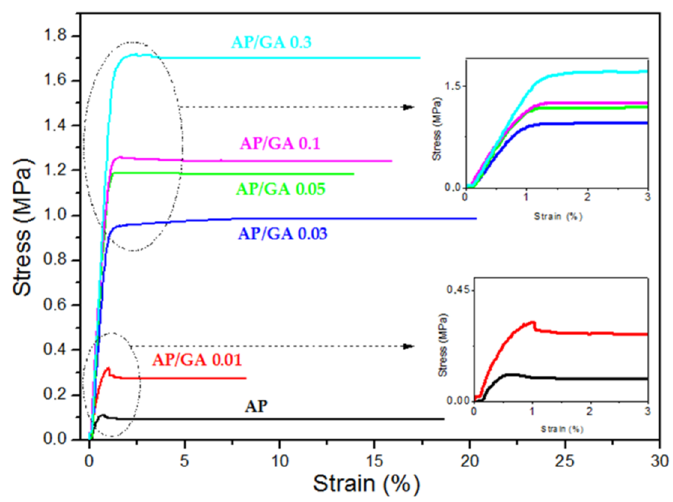
Figure 9. Stress/strain curves of AP and all the AP/GA coatings with a magnification of the yielding area in the inset graphs. Table 3. Mechanical characterization of AP and AP/GA coatings.